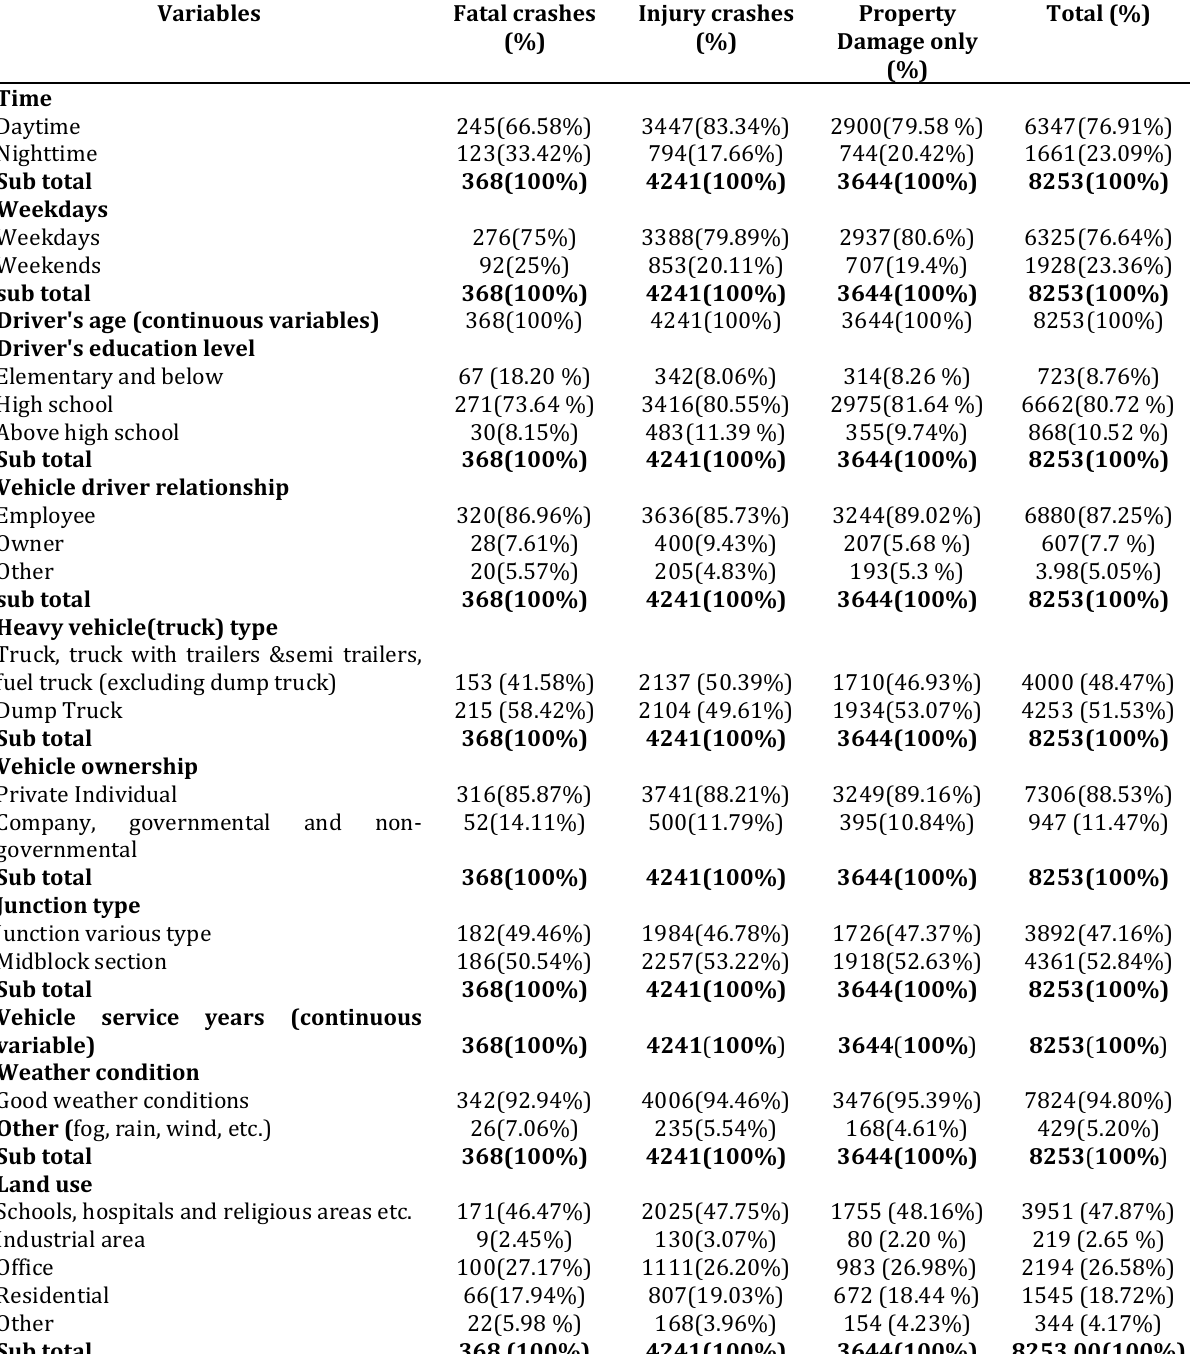
Table 1: Description of heavy vehicle crashes (July